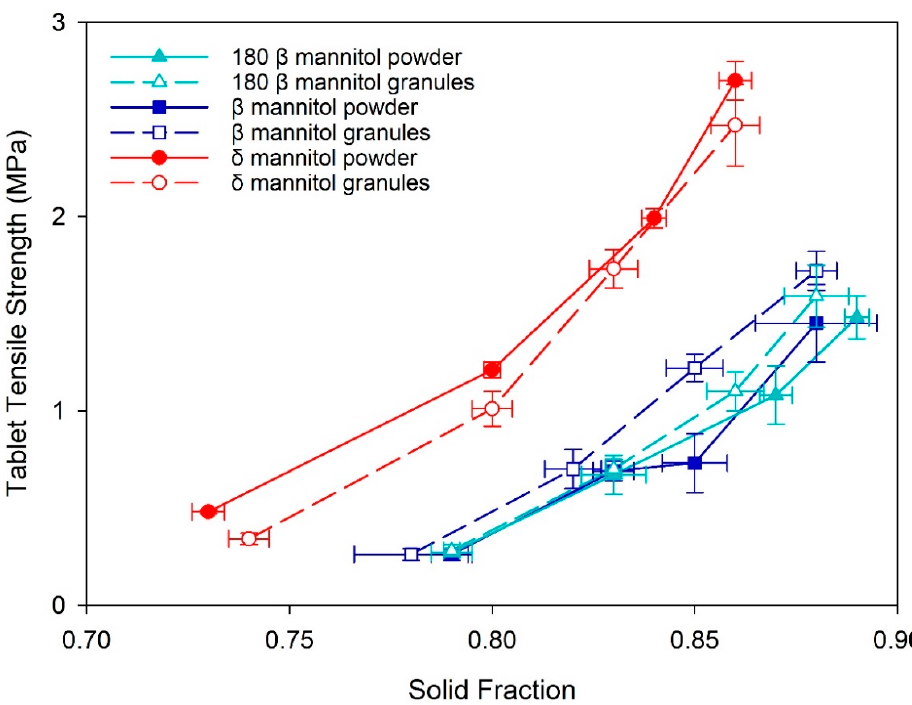
Figure 5. Compactability of δ mannitol, β mannitol, and 180 µm sieved β mannitol powder and granules. Arithmetic means of n = 10 ± S.D.